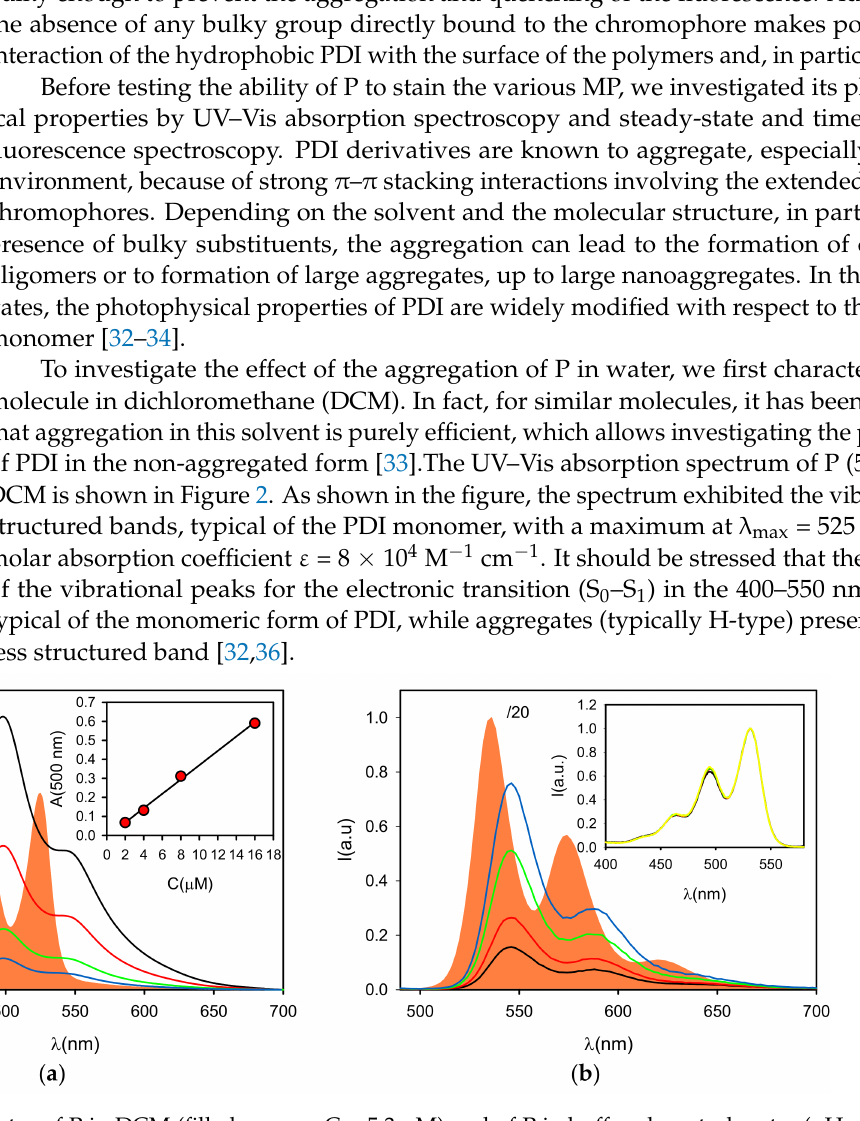
Figure 2. ( a ) Absorption spectra of P in DCM (filled orange, C = 5.3 µ M) and of P in buffered neutral water (pH = 7) at concentrations 16, 8, 4 and 2 µ M (black, red, green and blue lines, respectively). The absorbance at 500 nm as a function of the concentration is plotted in the inset. ( b ) Fluorescence spectra ( λ exc = 470 nm) of P in DCM (filled orange, C = 5.3 µ M, divided by 20 for scaling) and P in buffered neutral water (pH = 7) at concentrations 16, 8, 4 and 2 µ M (black, red, green and blue lines, respectively). The normalized excitation spectra for the four water solutions ( λ em = 580 nm) are shown in the inset (same color line). All fluorescence and excitation spectra are corrected for the inner filter